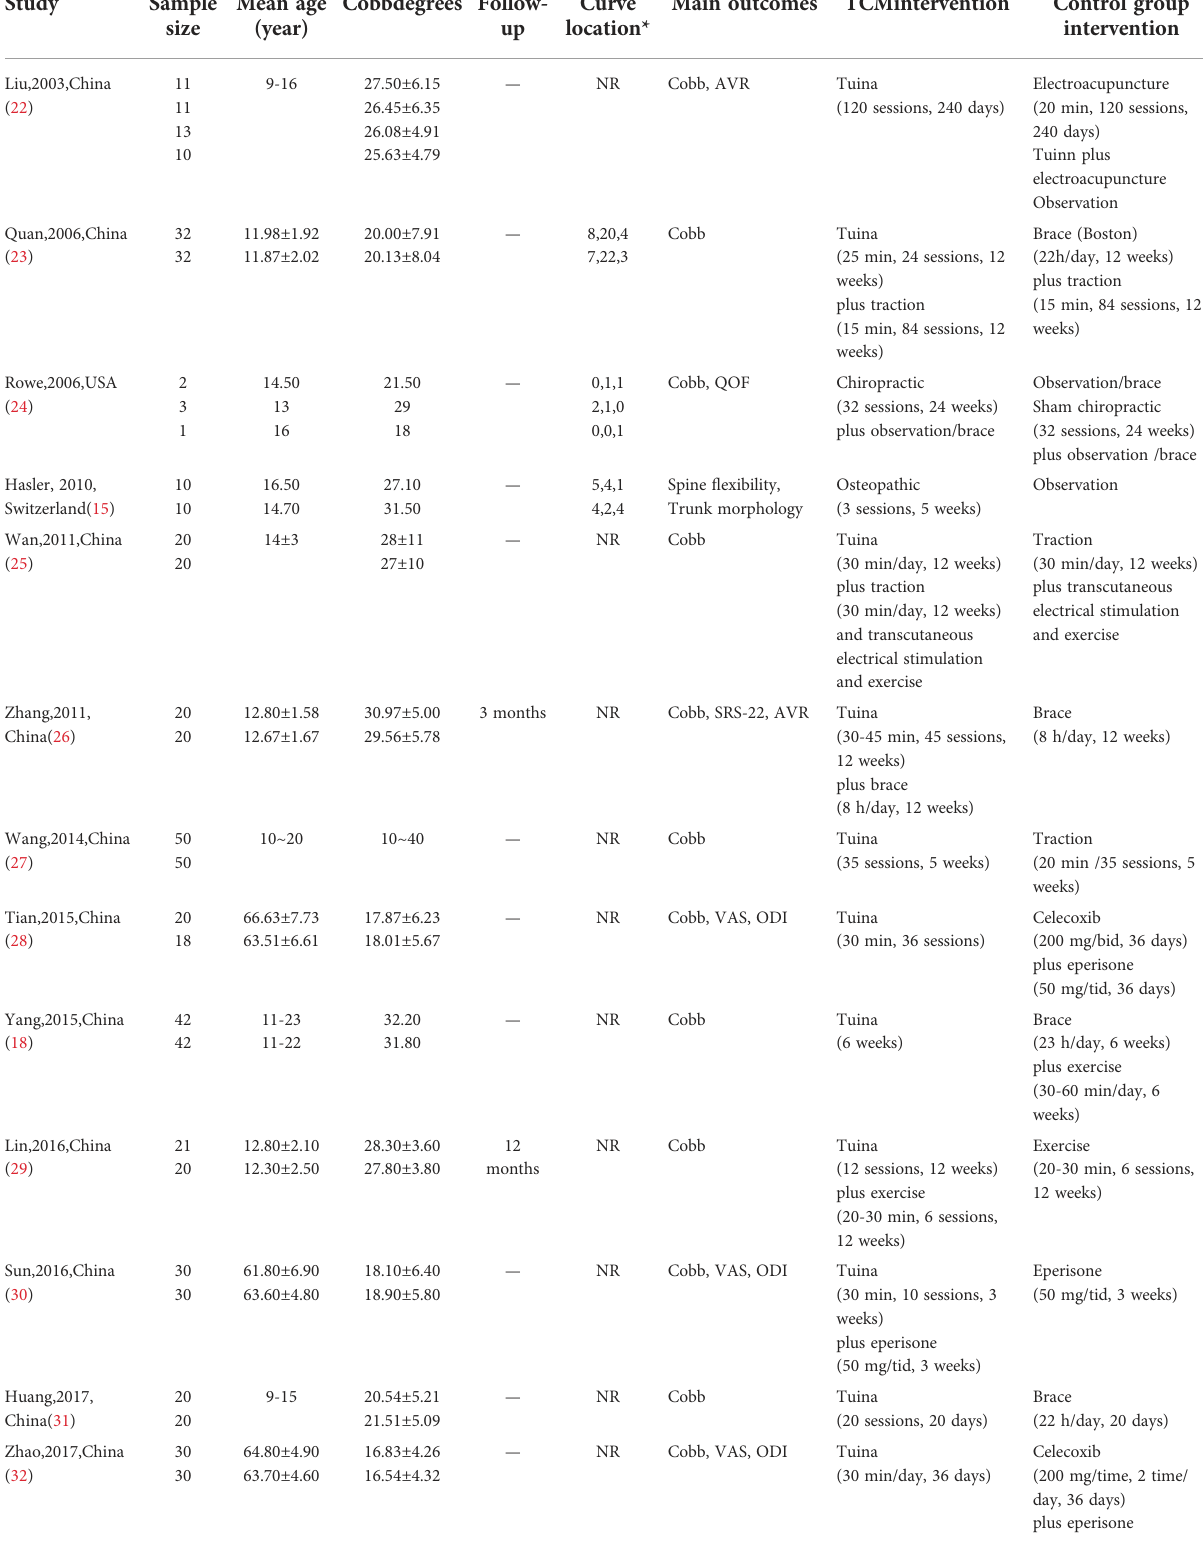
TABLE 1 Randomized controlled trials of manual therapy for idiopathic